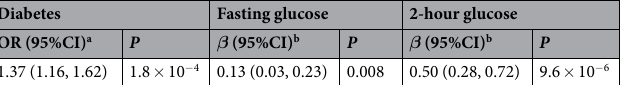
Table 4. Association of unit increase of the log-transformed CRP levels with diabetes prevalence and levels of fasting and 2-hour glucose. a The association was adjusted for gender, age, BMI, waist, SBP, DBP, hypertension, CVD, CHOL, HDL, TG, physical activity, smoking, and alcohol drinking. b The association was adjusted for gender, age, BMI, waist, SBP, DBP, hypertension, CVD, CHOL, HDL, TG, physical activity, smoking, alcohol drinking, and the use of medications for treating diabetes.